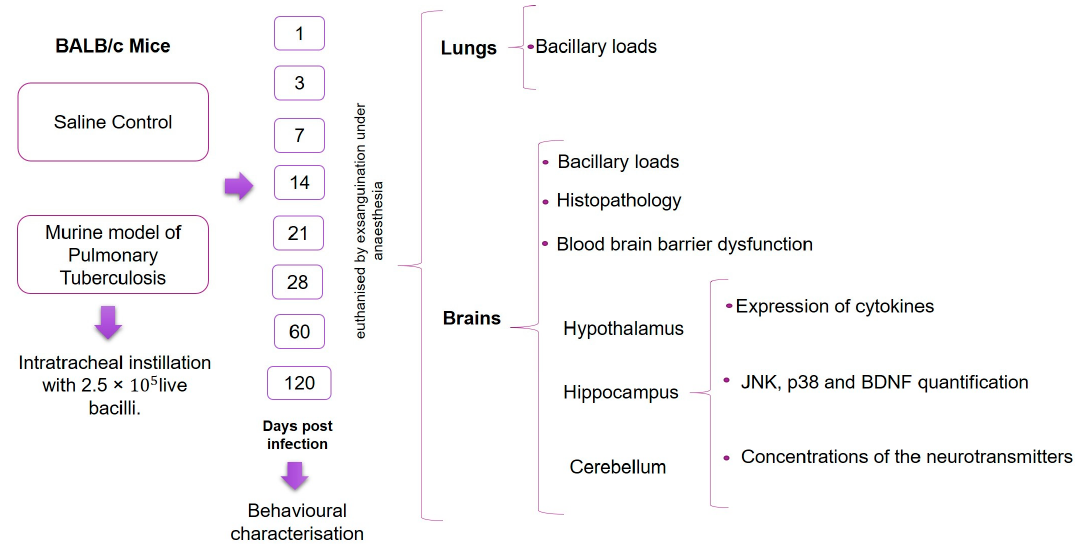
Figure 15. Study design workflow. BALB / c mice, 8 weeks of age, were infected with 2.5 × 10 5 live bacilli or received saline solution (control). At days 1, 3, 7, 14, 21, 28, 60 and 120 post-infection, di ff erent behavioural tests were performed. After the behavioural tests, animals were euthanised, and the brain and lungs were collected for the determination of bacillary loads. The hypothalamus, hippocampus and cerebellum were used to determinate the cytokines gene expression, JNK, p38 and BDNF quantification and the determination of neurotransmitters levels. In brains, histological damage and the permeability of the blood–brain barrier were also measured. For each of the measurements, except for the Western Blot, two independent experiments were performed with n = 3 each. The samples for each experimental age group were run